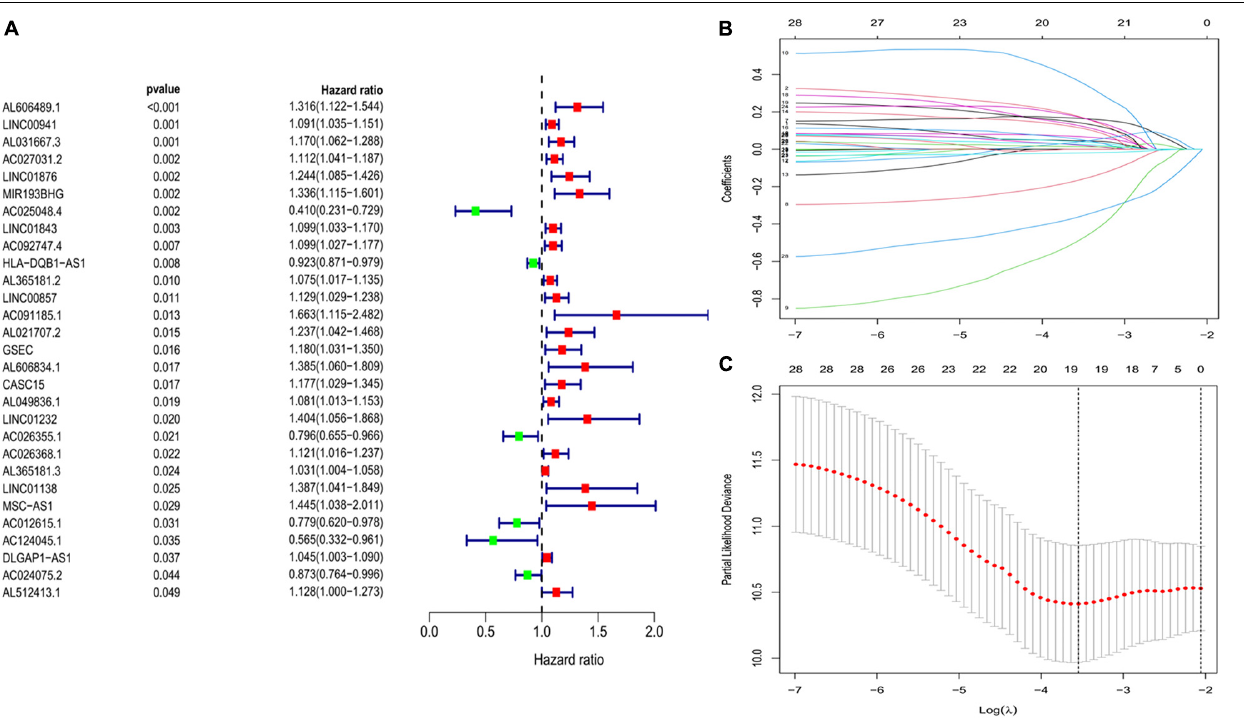
FIGURE 2 | Development of prognostic ferroptosis-associated lncRNA signature. (A) Forest plot of univariate Cox regression identified 29 ferroptosis-related lncRNAs associated with overall survival. (B,C) Lasso Cox regression to identify lncRNAs associated with ferroptosis that have implications for the prognosis of LUAD. lncRNAs, long non-coding RNAs; LASSO, least absolute shrinkage and selection operator; LUAD, lung adenocarcinoma.